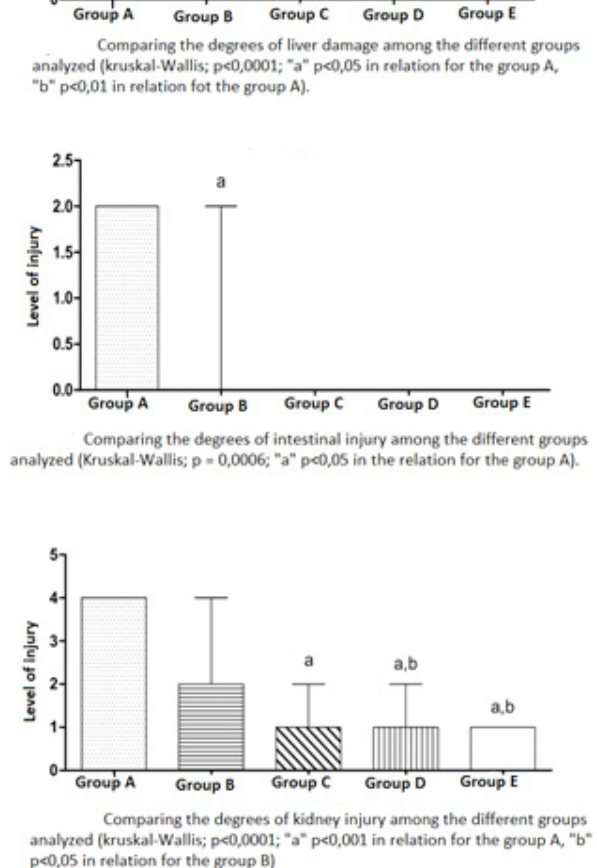
Fig. 4 – Graphics analyzing the level of injury among tissues in each